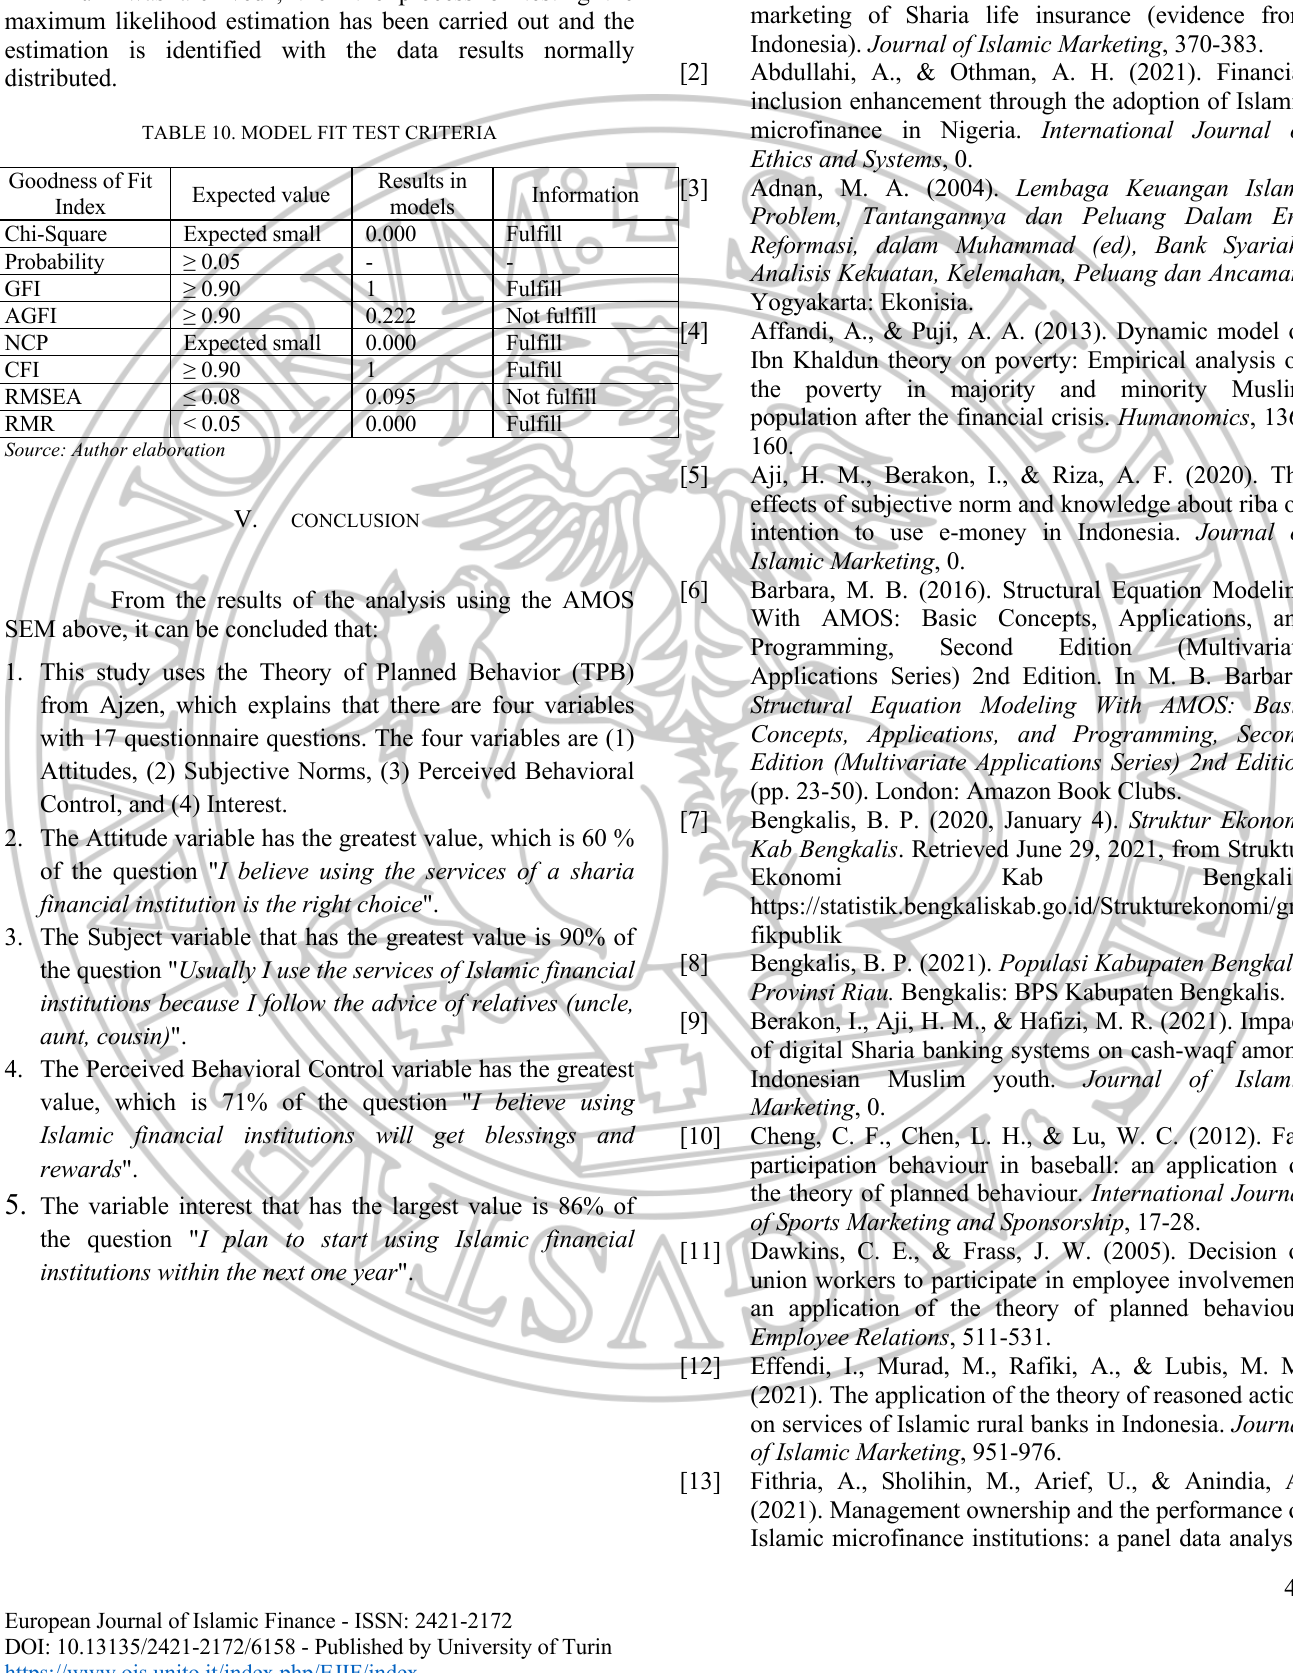
TABLE 10. MODEL FIT TEST